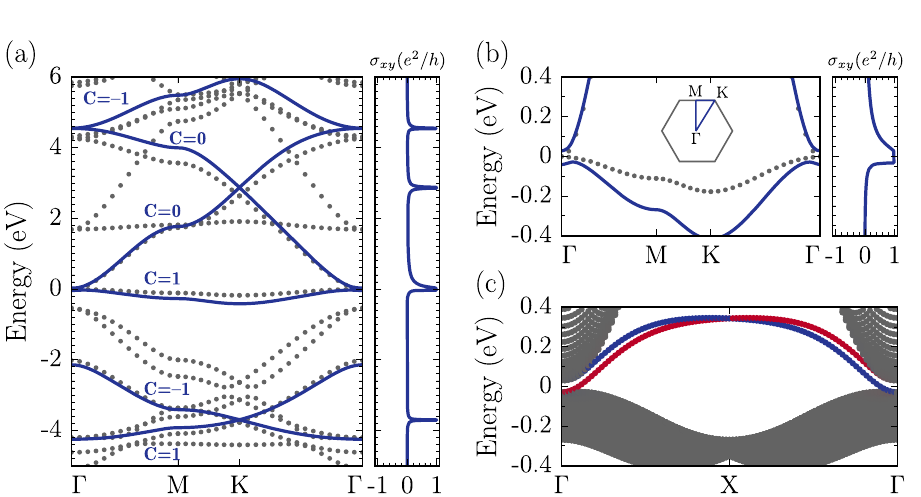
Figure 6. Tight-binding modeling. ( a ) The spin-up band structure of B 9 -KL under 18% strain and ( b ) its magnified view near the Fermi level along high symmetry lines, with the Hall conductances on the right panels. Gray dots stand for the HSE06 band structure and blue curves represent the band structure derived from the effective tight-binding model with including the SOC. ( c ) The band structure of the B 9 -KL ribbon with a width of 50 unit cells. Blue and red curves stand for the chiral bands associated with the different